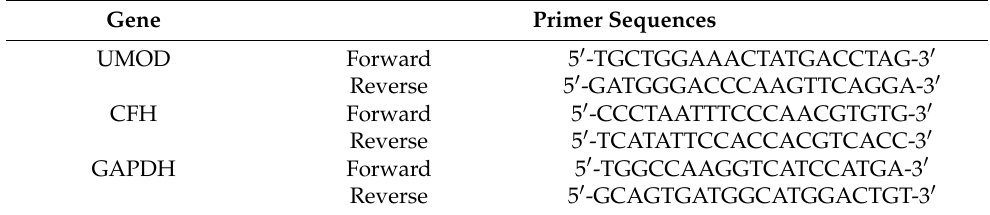
Table 1. Primer sequences used for